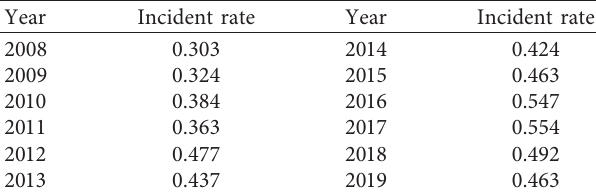
Table 1: Civil aviation incident rate in China from 2008 to 2019.